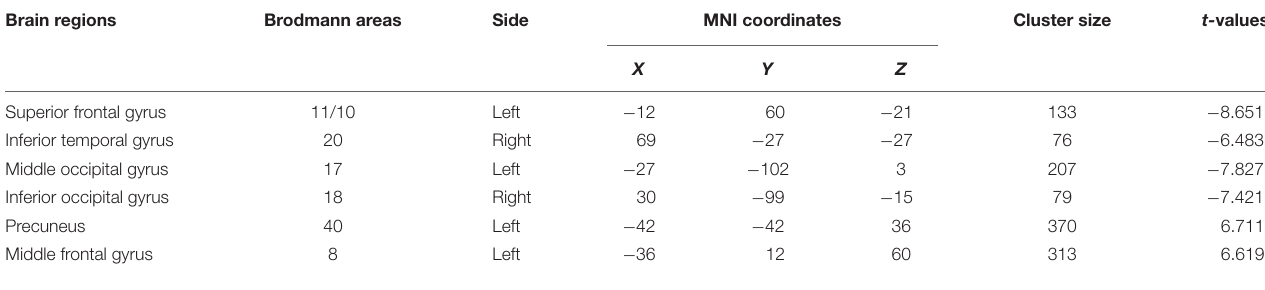
TABLE 3 | Brain regions in ALFF between MDD and healthy controls. Brain